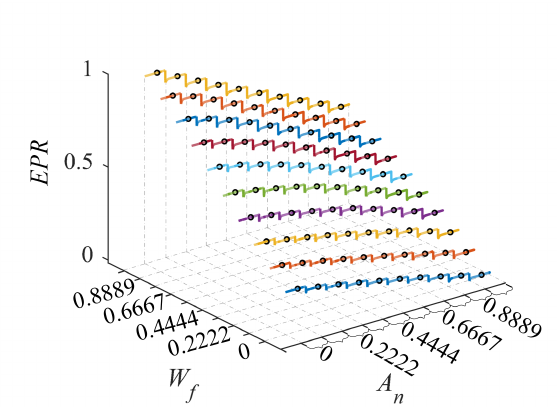
Figure 4. The simulation results of EPR under ten simulation